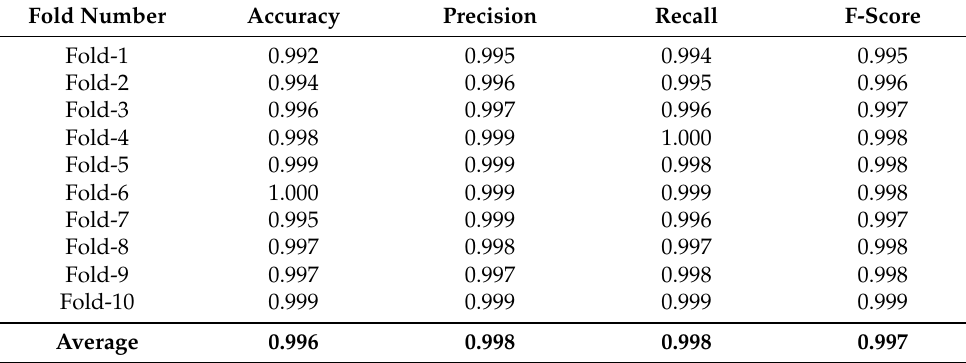
Table 4. Proposed approach k-fold cross-validation result.